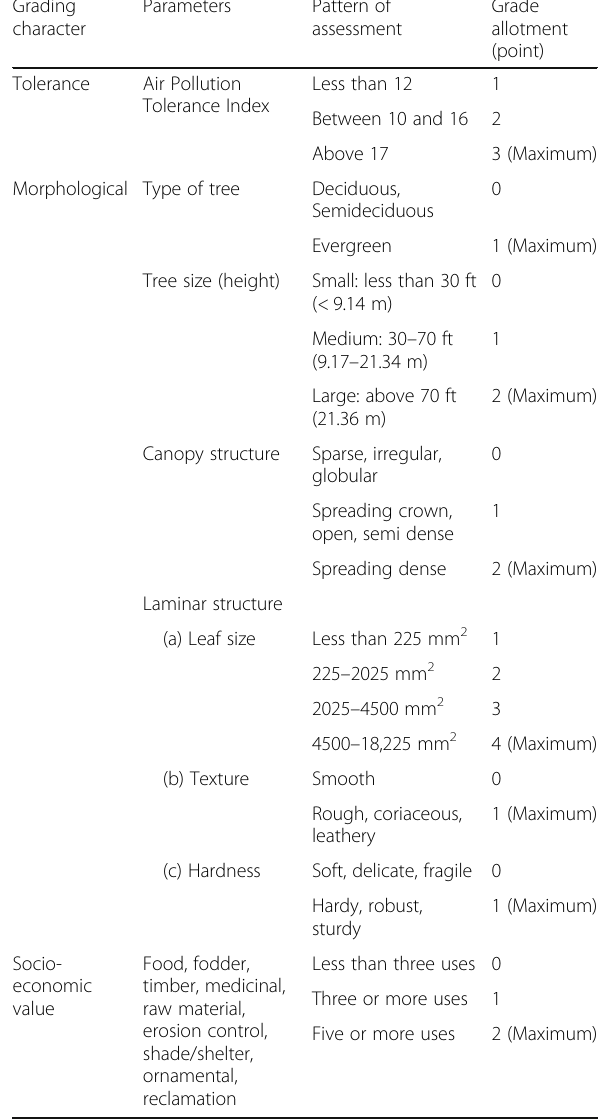
index, morphological parameters and